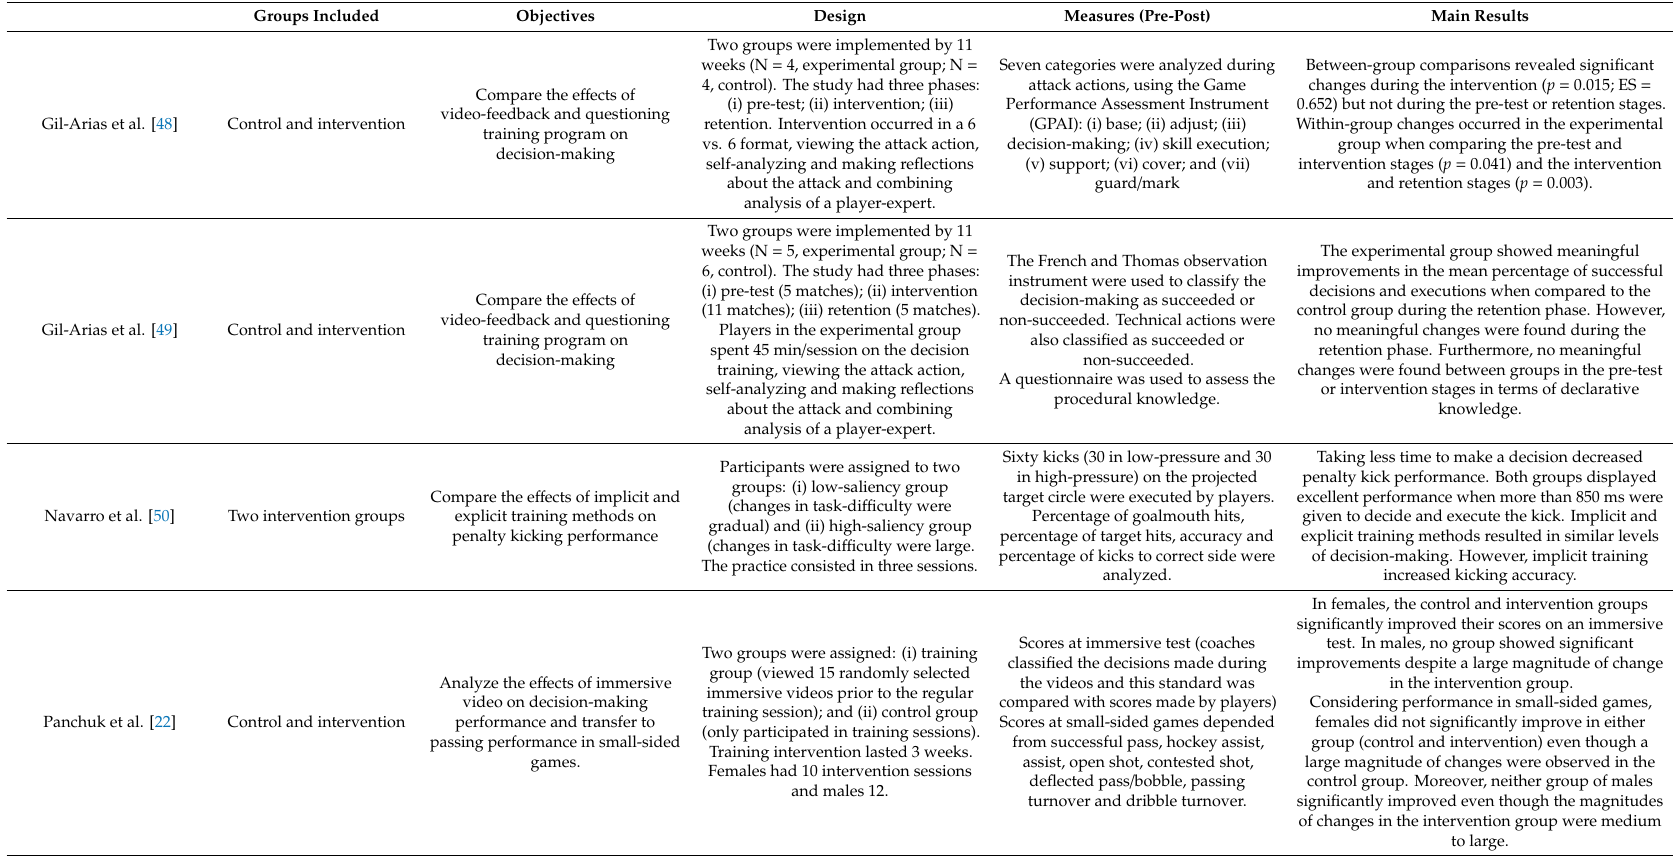
Table 4. Studies that analyzed the e ff ects of training programs on decision-making in youth team-sports